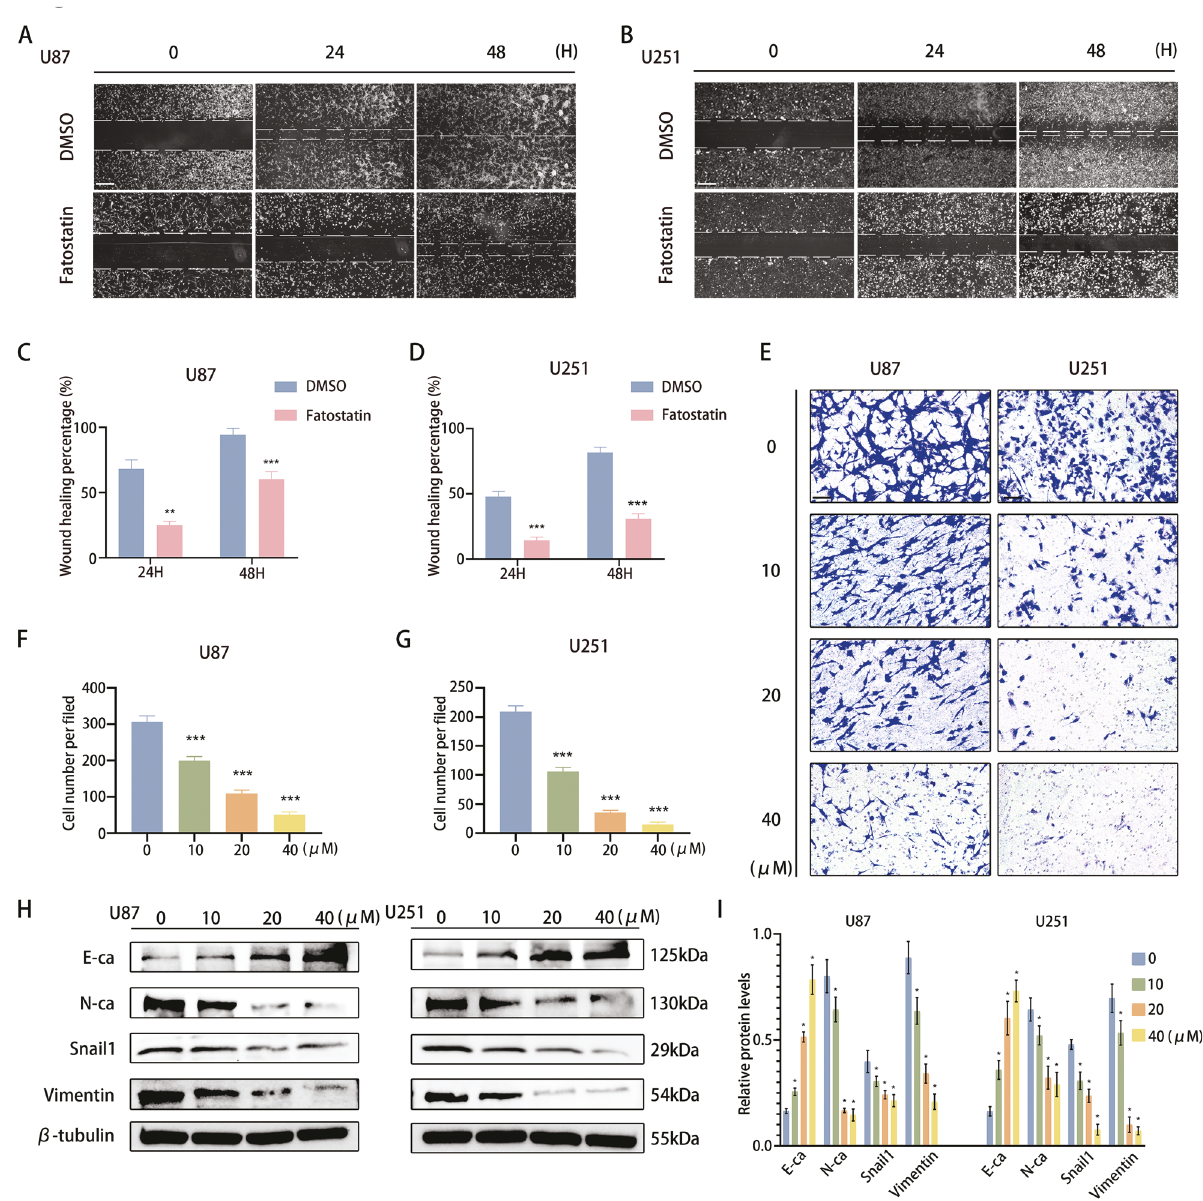
Fig. 3 Fatostatin attenuates the EMT process of GBM cells. A – D Wound-healing assays were used to detect the migration of U87 and U251 cells after fatostatin treatment. Scale bars: 200 µm. E – G Transwell assays were used to detect the invasion of U87 and U251 cells after fatostatin treatment. Scale bars: 50 µm. H , I Western blot analysis was used to detect the expression of E-ca, N-ca, Snail1, and Vimentin in U87 and U251 cells after fatostatin treatment for 24 h. * P < 0.05, ** P < 0.01, *** P <